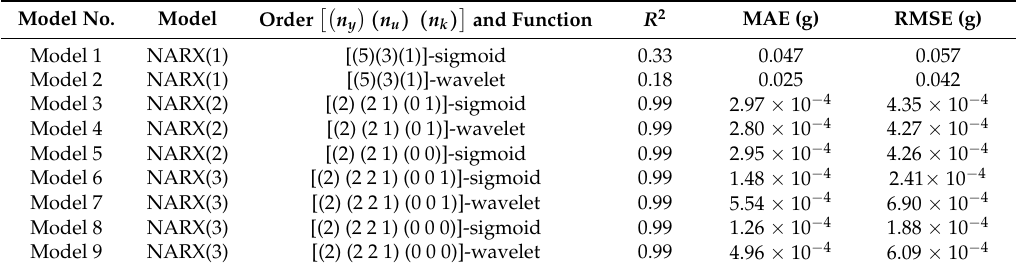
Table 2. Statistical parameter used for the evaluation of Nonlinear AutoRegresive with eXogenous inputs (NARX)